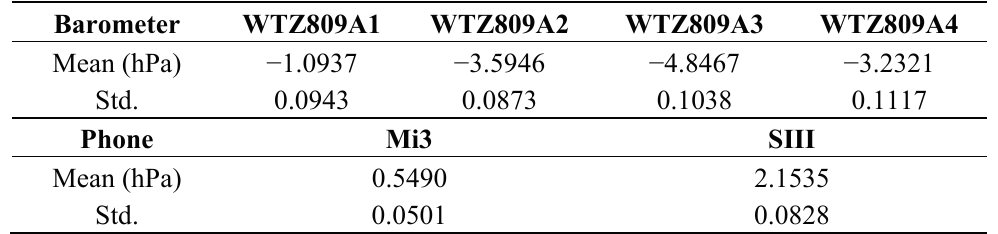
Table 4. Means and standard deviations of the offsets using UG801 as